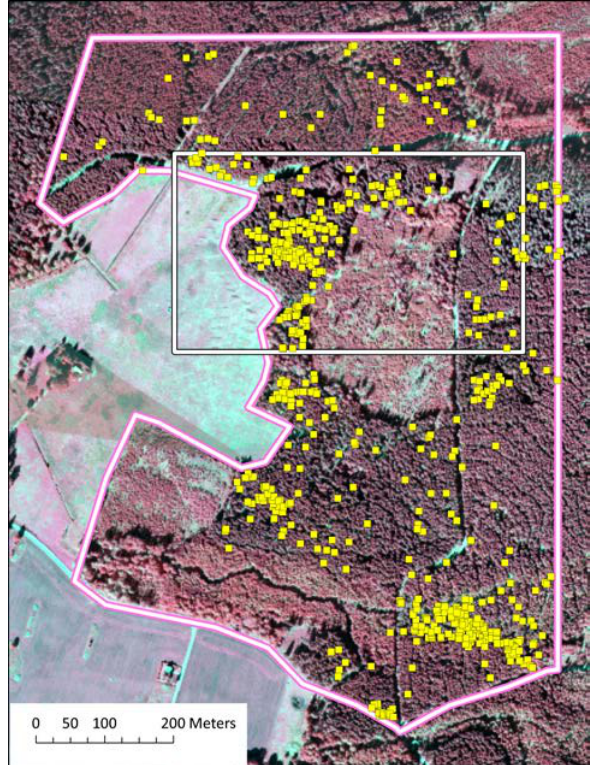
Figure 1. Study area with field-measured lying tree stems (yellow dots) on a false colour composite aerial image. The pink boundary marks the inventory area. The white box contains a big pile of storm-felled trees (left-middle), low vegetation with few or no storm-felled trees (middle) and single storm-felled trees (right). To the right of the low vegetation is a road in north-south direction. To the left of the pink boundary is an agricultural field outside of the inventory area where stems have been intentionally placed but not included in the field